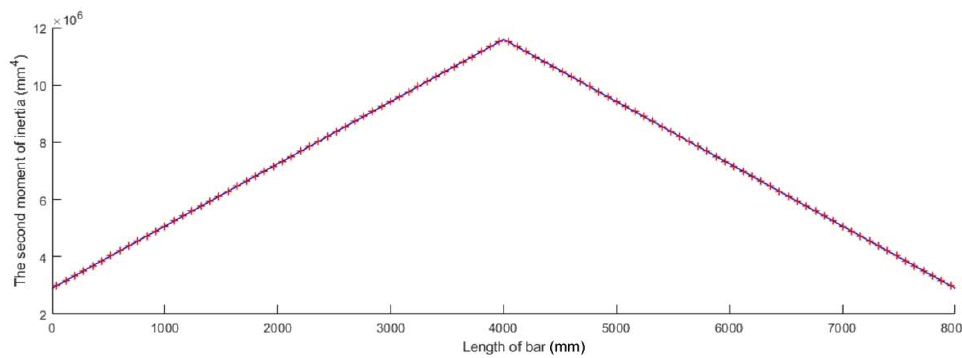
Figure 9. Triangular variation in the second moment of inertia along the bar axis.